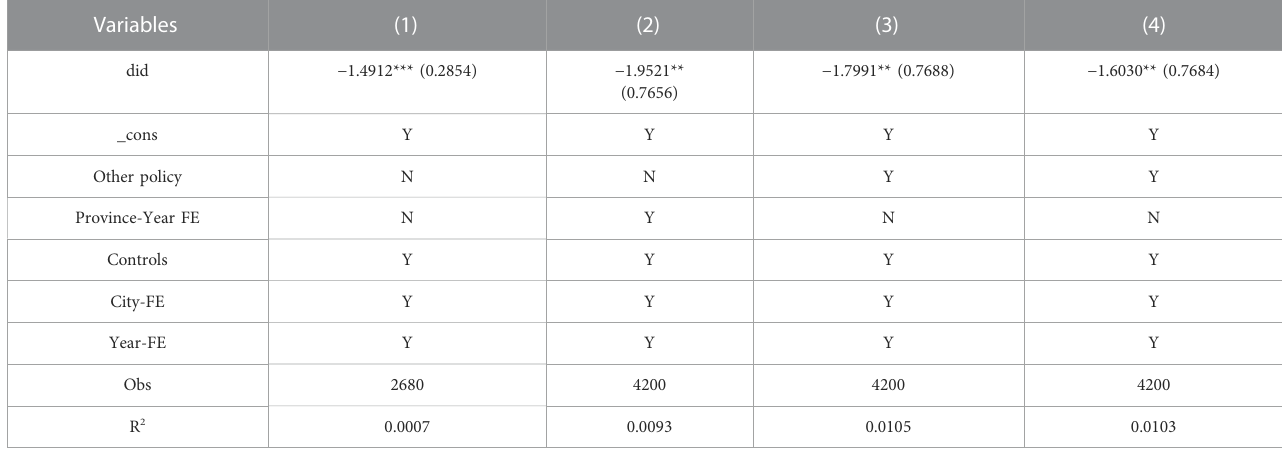
TABLE 4 Robustness test results.